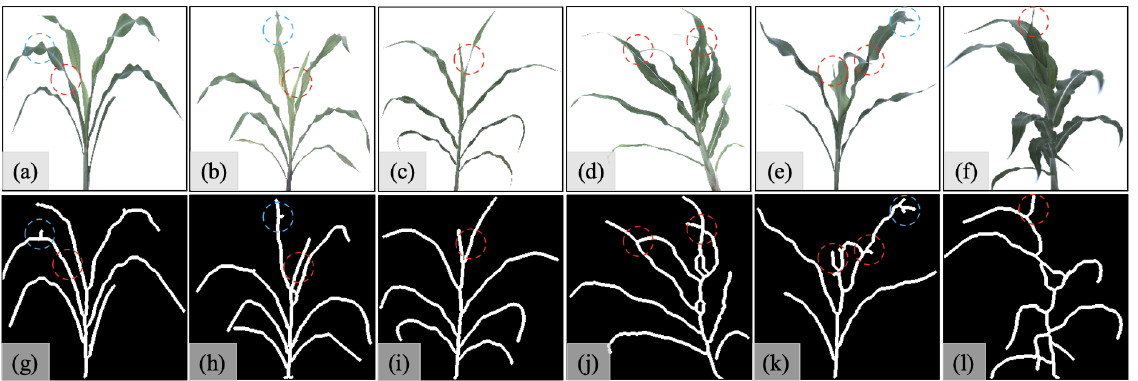
Figure 6. Dataset description: ( a – c ) are examples of original sorghum images in dataset S1O; ( d – f ) are examples of original sorghum images in dataset S2O; ( g – i ) correspond skeleton structure images S1S for ( a – c ); ( j – l ) correspond skeleton structure images S2S for ( d – f)